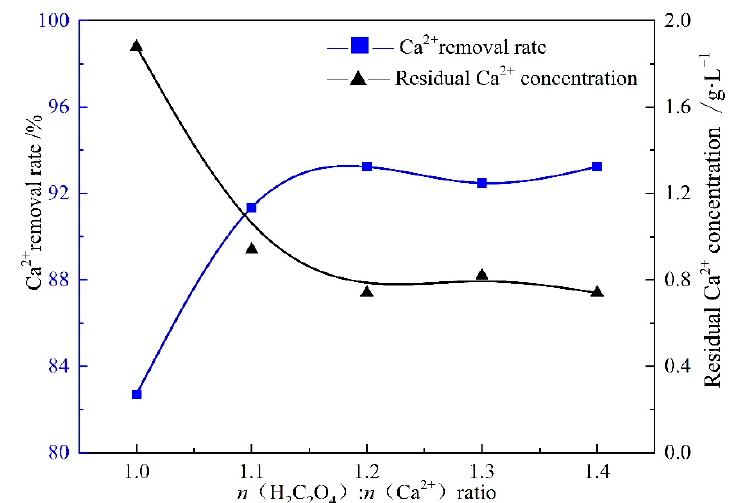
Figure 3. The influence of n( H 2 C 2 O 4 ): n( Ca 2+ ) on the removal rate of Ca 2+